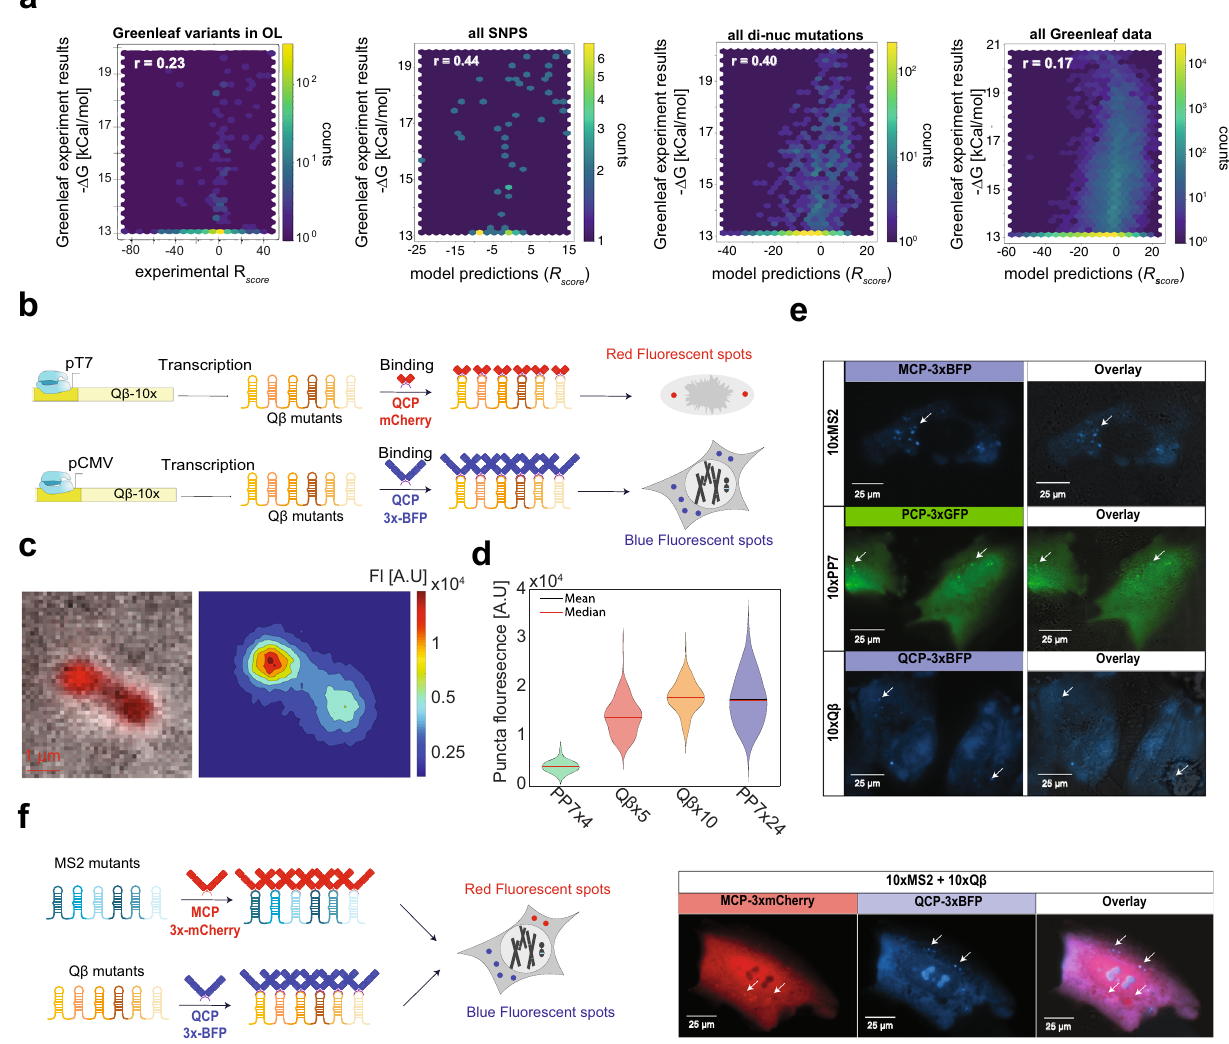
Fig. 5 Validations: cassettes for RNA imaging in U2OS cells. a R score comparison to Δ G results of a previous study that reported MCP binding to more than 129k sequences 27 . Each plot (from left to right) represents Pearson correlation coef fi cient using: the experimental measurements for variants that were both in our OL and in the in vitro study, the R score values predicted by our ML model for all single-mutation variants, for all double-mutation variants, and for the entire set of 129,248 mutated variants. b Example experiment design for bacterial and mammalian cells. High R score binding sites were incorporated into a ten-site cassette downstream to either a T7 promoter in E. coli or a mammalian CMV promoter. When the matching QCP-mCherry for bacteria (top) or QCP-3xBFP for mammalian cells (bottom) are added, it binds the binding site cassette and creates a fl uorescent spot. c Fluorescent image of typical bacterial cell depicting bright puncta in cell pole. (Left) Raw image. (Right) Processed image depicting variations in brightness density. d Violin plots of mean spot intensity measured in bacteria expressing the different binding sites cassettes. Values are based on the following number of captured cells taken on multiple days (from left to right): 99 (PP7-4x), 149 (Q β -5x), 187 (Q β -10x), 182 (PP7-24x). e The results for three CP-speci fi c cassettes transfected with the matching CP-3xFP plasmid into U2OS cells and imaged by fl uorescence microscopy for detection of fl uorescent foci . For each experiment, both the relevant fl uorescent channel and the merged images with the differential interference contrast (DIC) channel are presented. Each experiment was successfully conducted in duplicates and on two different days. f (Left) Experimental design for the orthogonality experiment: two separate cassettes with 10 predicted mutated sites for either MCP only or QCP only, respectively, were designed and transfected together with both MCP- 3xmCherry and QCP-3xBFP, into U2OS cells. (Right) Results for the orthogonality experiment: a cell presenting non-overlapping fl uorescent foci from both fl uorescent channels, indicating binding of MCP and QCP to different targets. This experiment was successfully conducted in duplicate and on two different days. Fluorescent wavelengths used in these experiments are: 400 nm for BFP, 490 nm for GFP, and 585 nm for mCherry. Source data are provided as a Source data fi